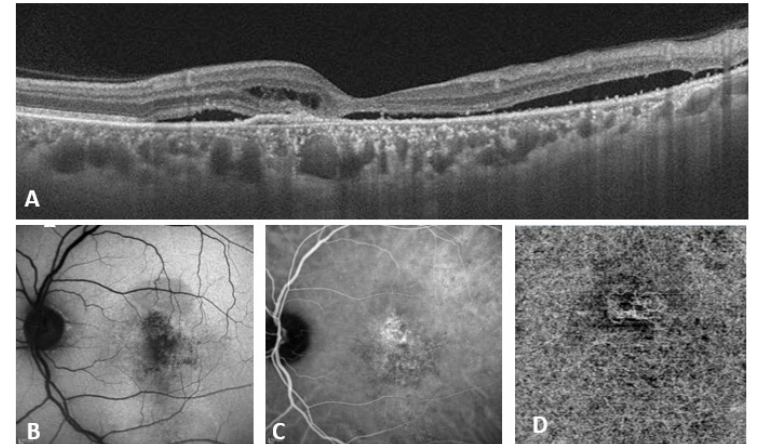
Figure 2. Eye of a 47-year-old male with a visual acuity of 20/320 and duration of complaints for 2 years. ( A ) OCT (B scan) passing through the fovea shows intraretinal and subretinal fluid along with flat irregular pigment epithelium detachment, suspicious for likely CNV. ( B ) Demonstrates > 2 DD area of RPE abnormality (Complex CSCR). ( C , D ) show corresponding ICG-A and OCTA, respectively, that confirm the choroidal neovascular complex in the outer retina and choriocapillaris slab.